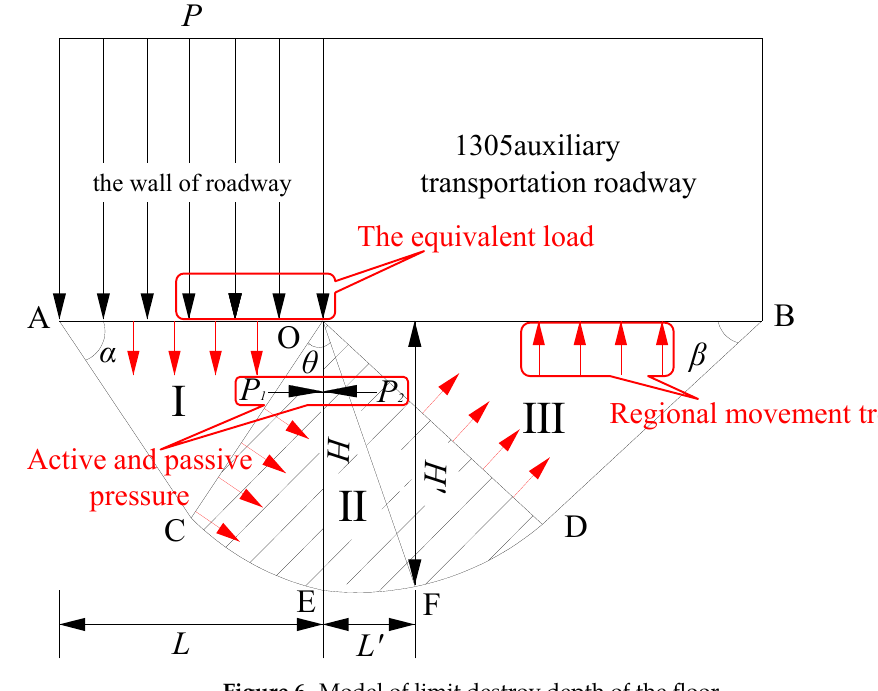
Figure 6. Model of limit destroy depth of the floor.